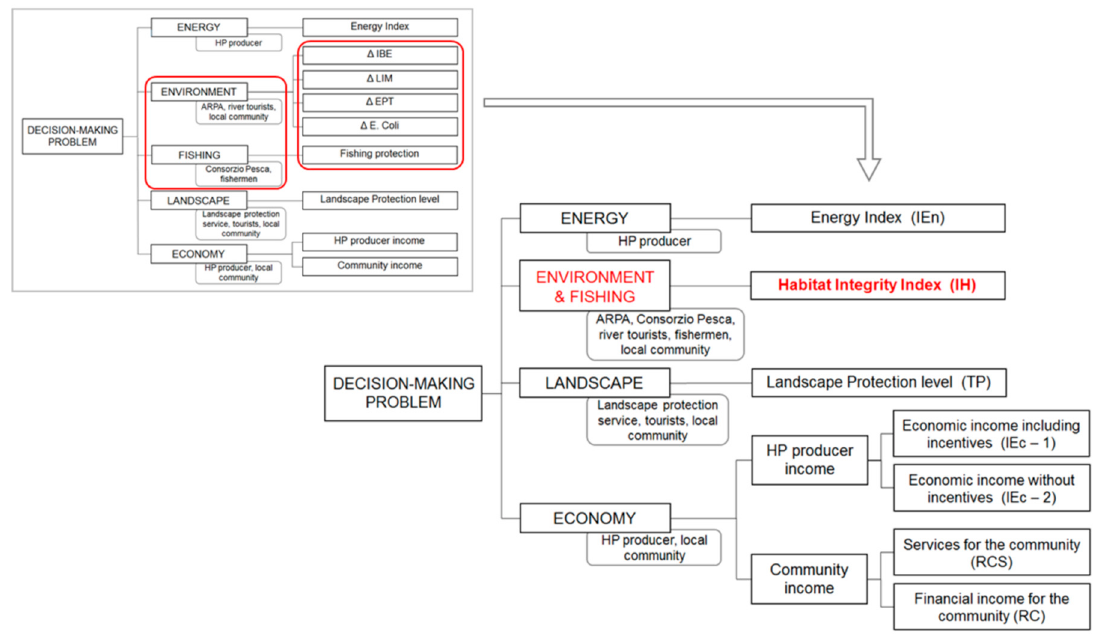
Figure 6. Final decisional tree considered in Aosta Valley MCA for decision-making processes to support the withdrawal sustainability assessment (on the right). It can be noticed that, compared to the previous decisional tree (shown in the upper left corner), the IH indicator (highlighted in red) has been introduced, related to the “environment and fishing” criterion; besides, the economy criterion has been further divided in two sub-criteria (i.e., “HP producer income” and “community income”), both quantified by two indicators each.